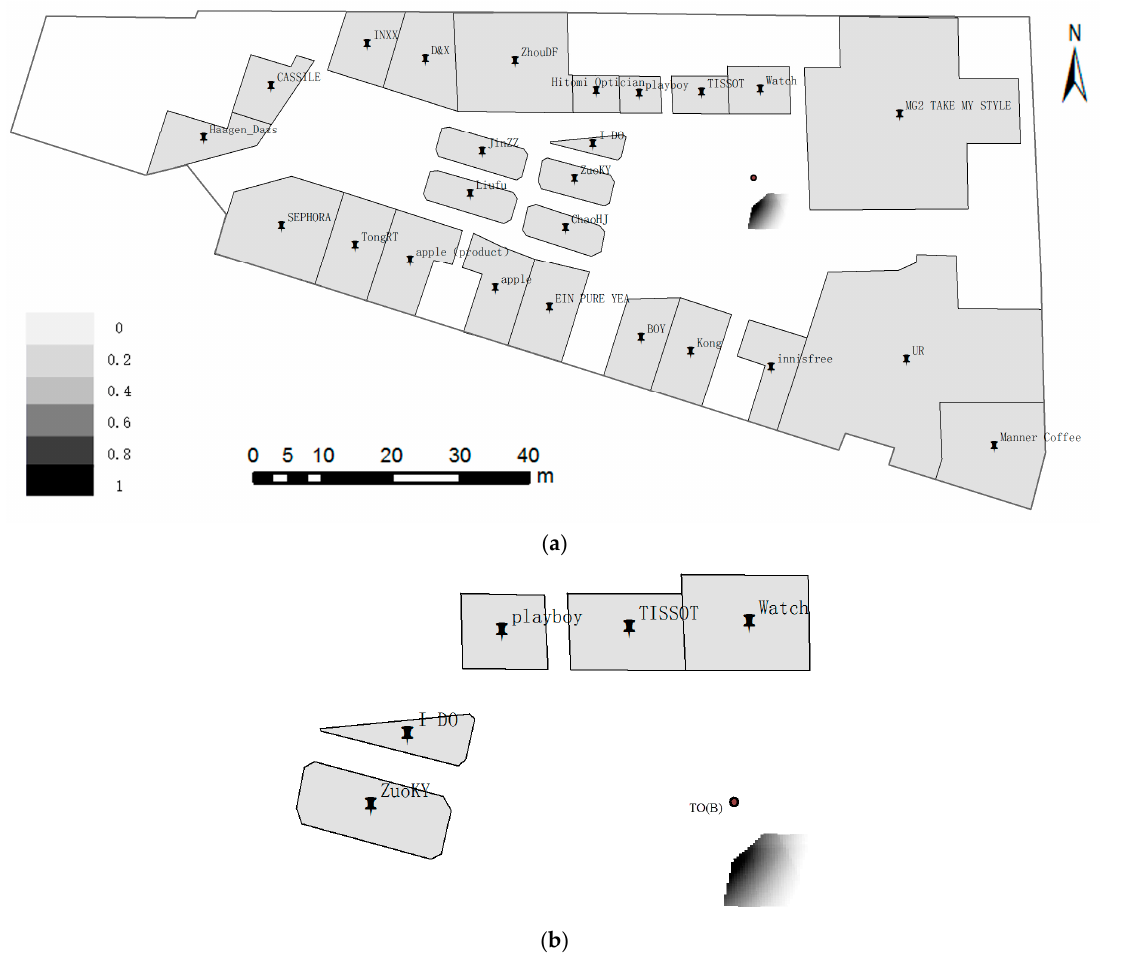
Figure 14. Positioning with three ROs at point TO(B) approximately 14.4 m away from Watch. The locality description is “front 20 m is Watch, left–front 30 m is Playboy, and left 30 m is ZuoKY.” ( a ) Global; and ( b ) Local.